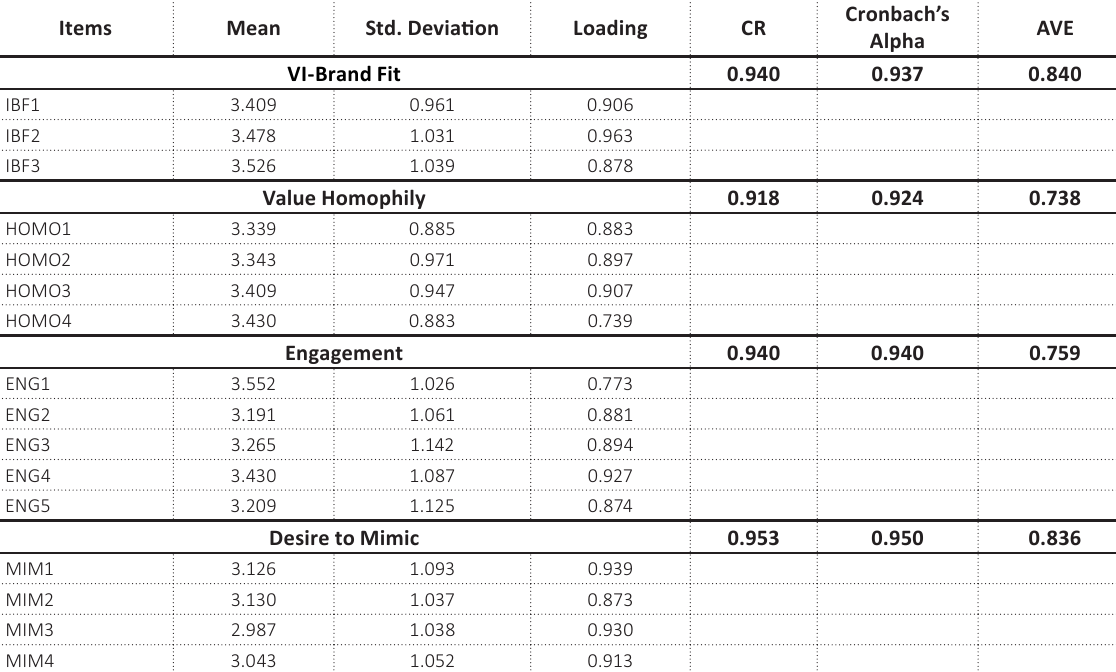
Table 1. Reliability and convergent validity of the